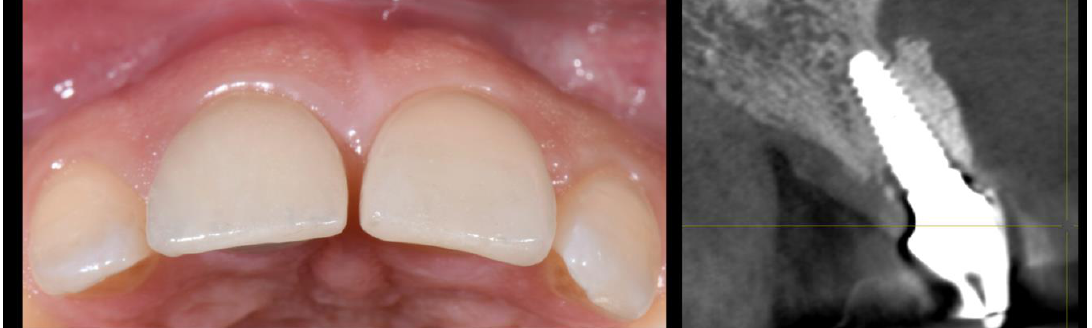
Figure 20. Clinical and radiographic re-evaluation 2 years post loading.